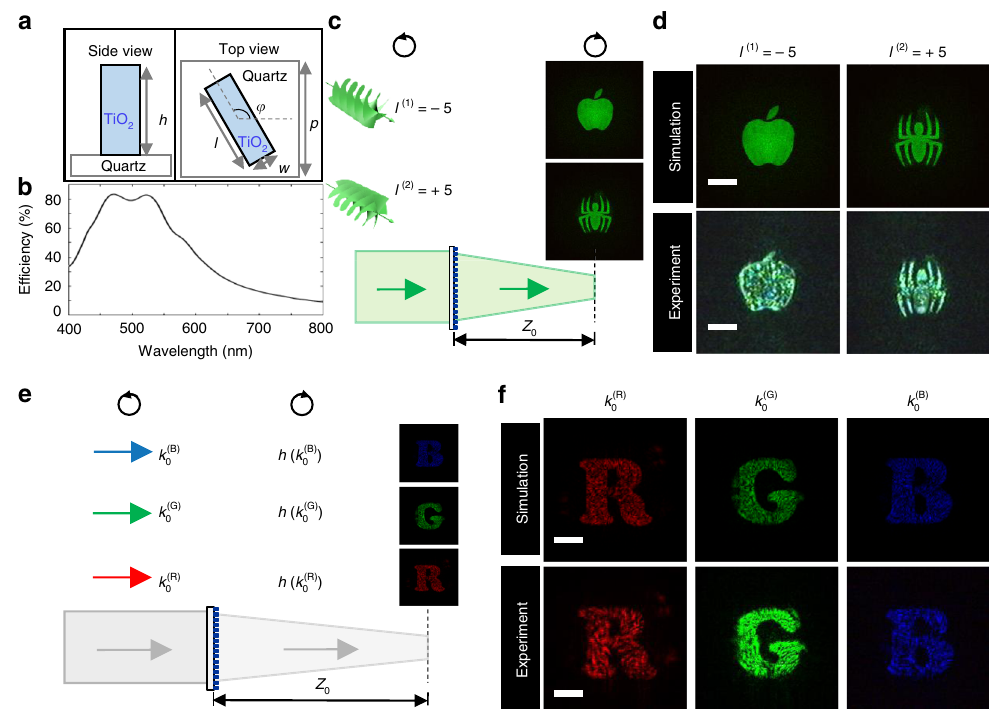
Fig. 2 Principle and demonstration of multi-momentum meta-transformer. a Geometry of the designed unit cell structure representing one pixel in the meta- transformer, with the periodicity of 325nm. The TiO 2 nano- fi n parameters are w = 80nm, l = 250 nm, and h = 600 nm. The in-plane rotating angle φ of nano- fi n will introduce the geometric phase of 2 φ for the incident beam with RCP. b Measured conversion ef fi ciency of the meta-transformer. The conversion ef fi ciency is de fi ned as the optical power of the transmitted light with opposite CP divided by the incident optical power. c Design principle of OAM meta-transformer. Under the illumination of vortex beam 1 ( l (1) = − 5) with RCP, the transmitted beam with opposite CP carries the total phase pro fi le ψ x ; y ð 0 0 OAM ¼(cid:2) 5